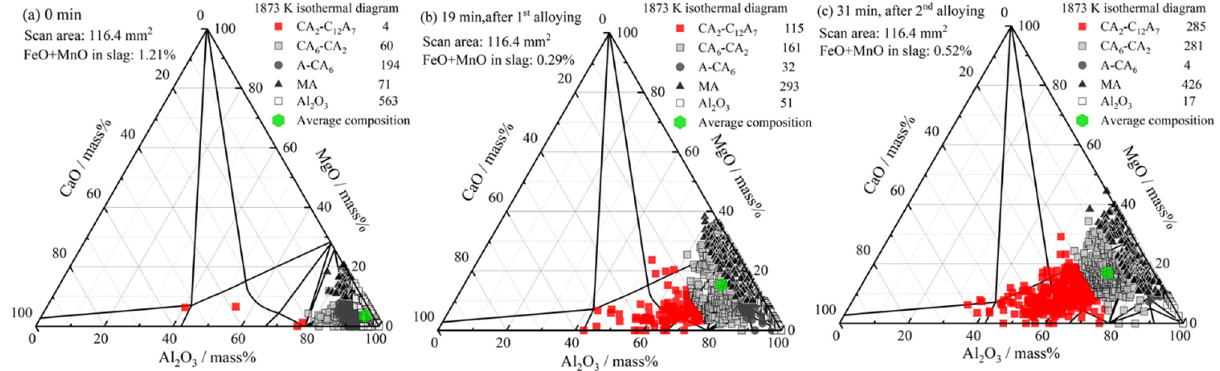
Figure 14. Observed inclusions in heat 3 at ( a ) 0 min, ( b ) 19 min after the 1st alloying, and ( c ) 31 min after the 2nd alloying.